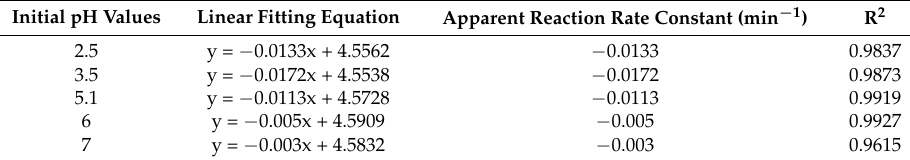
Table 5. Apparent reaction rate constant of different initial pH values.